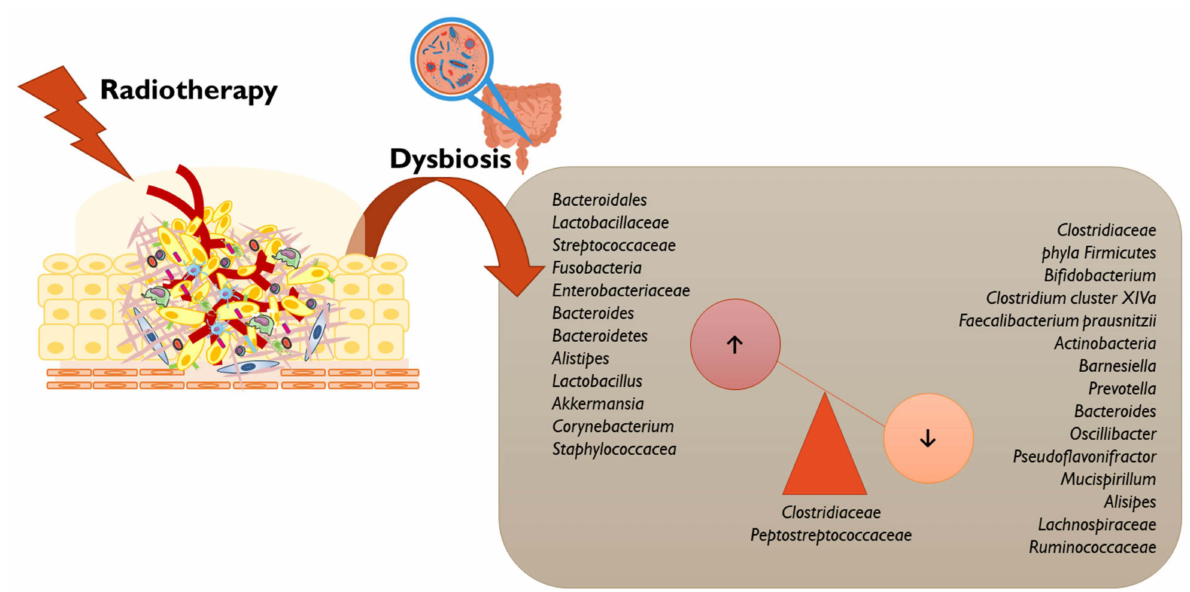
Figure 5. Radiotherapy may compromise the gut microbiota homeostasis by the imbalance of some genera, as depicted